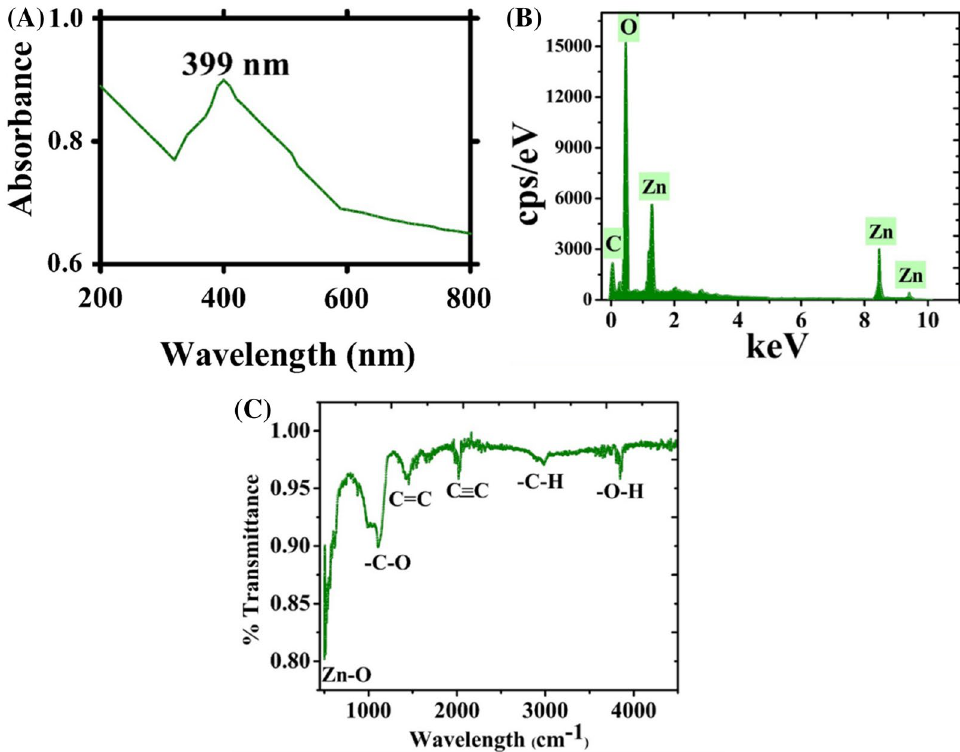
Figure 1. ( a ) UV visible spectroscopy, EDX and FTIR analysis of ZnONPs ( a ) UV; ( b ) EDX; ( c )